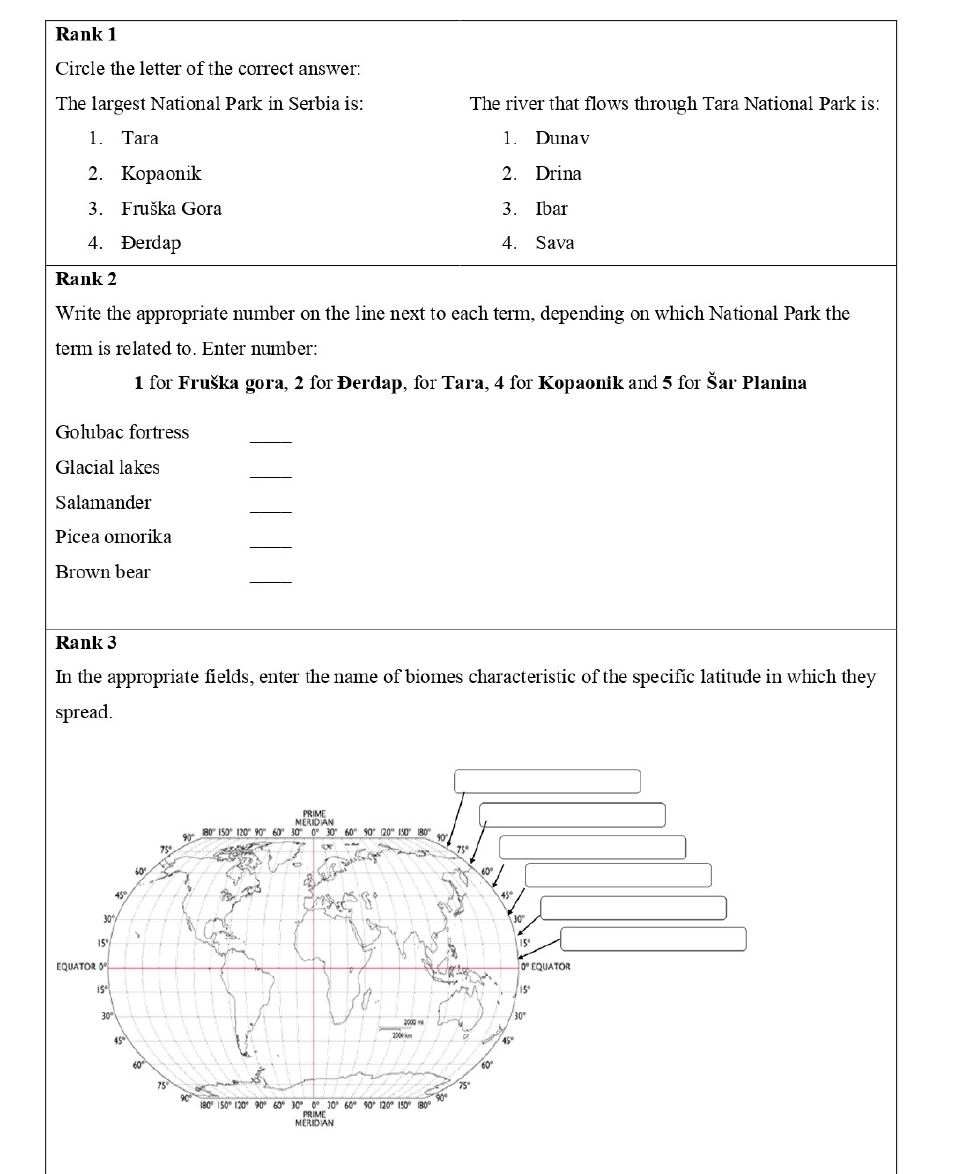
Figure 3. Example of some tasks used as an Indicator of Ranks 1, 2 and 3